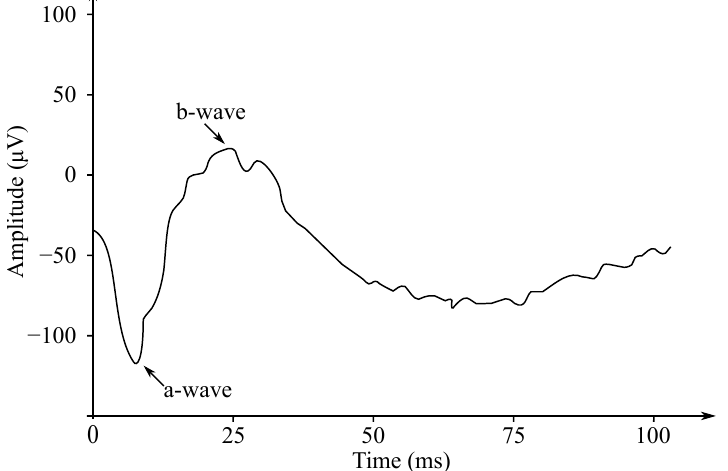
Figure 12. The biphasic waveform of a healthy patient—the negative wave ( a ) and the positive wave ( b